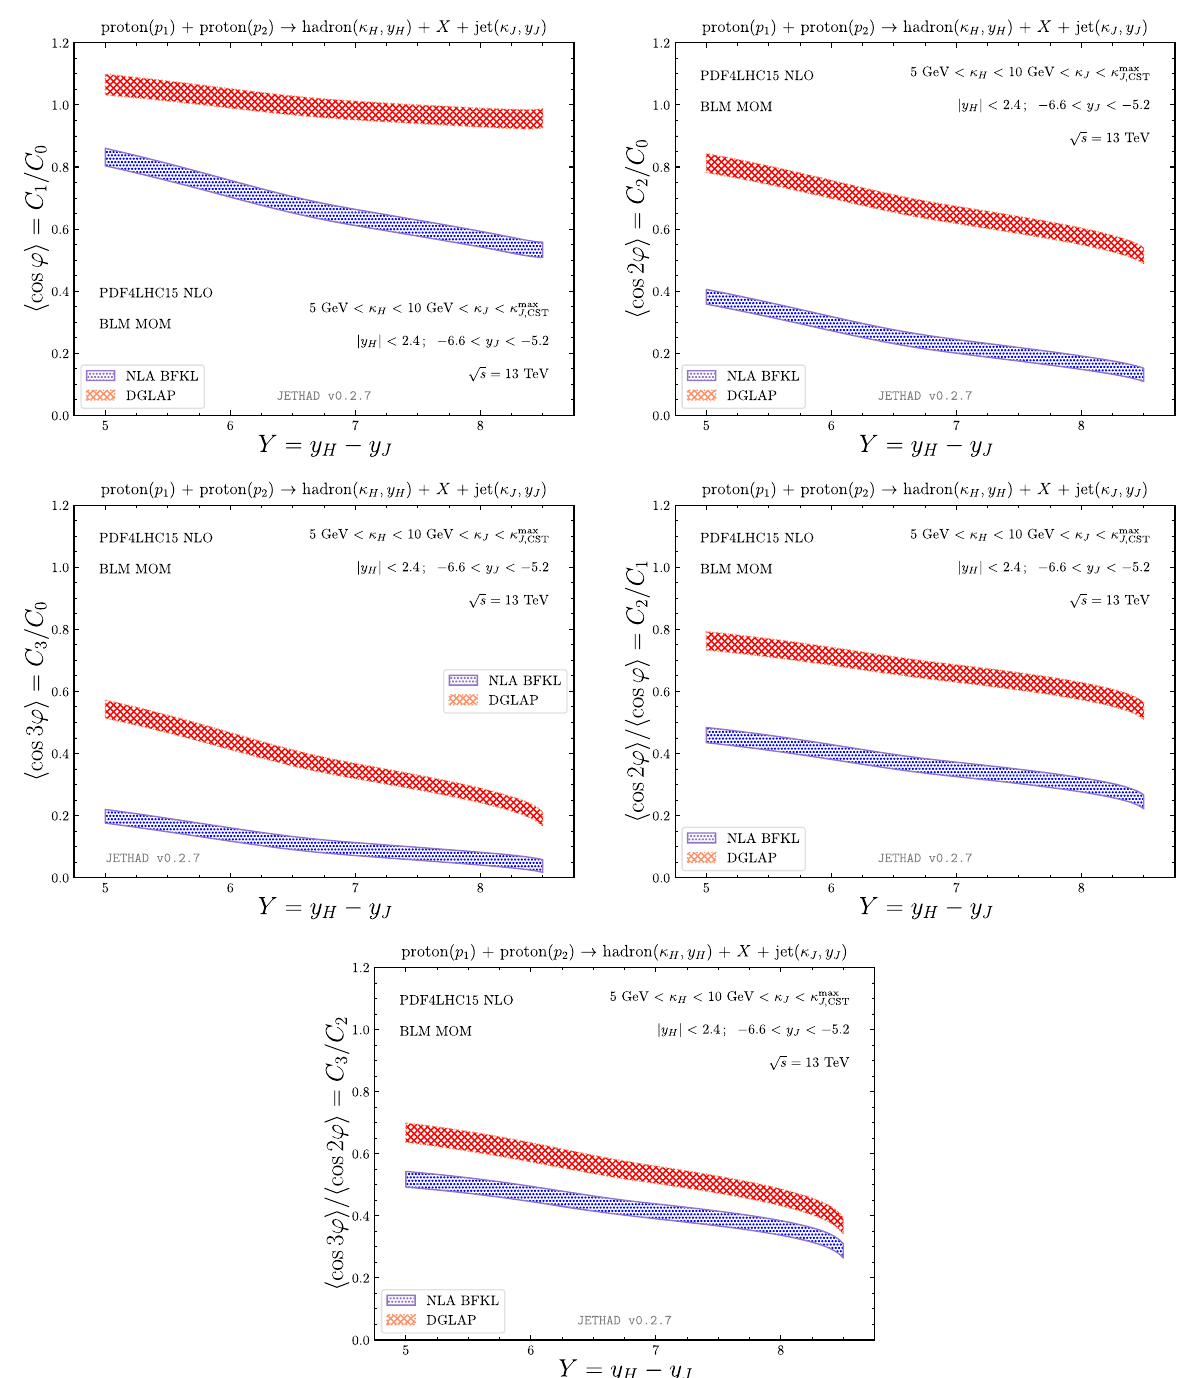
Fig. 14 Y -dependence of several azimuthal correlations, R nm ≡ C n / C m , of the inclusive hadron-jet production (central panel of Fig. 2) √ s = 13 TeV ( CASTOR-jet configu- for μ F 1 , 2 = μ R = μ BLM and R